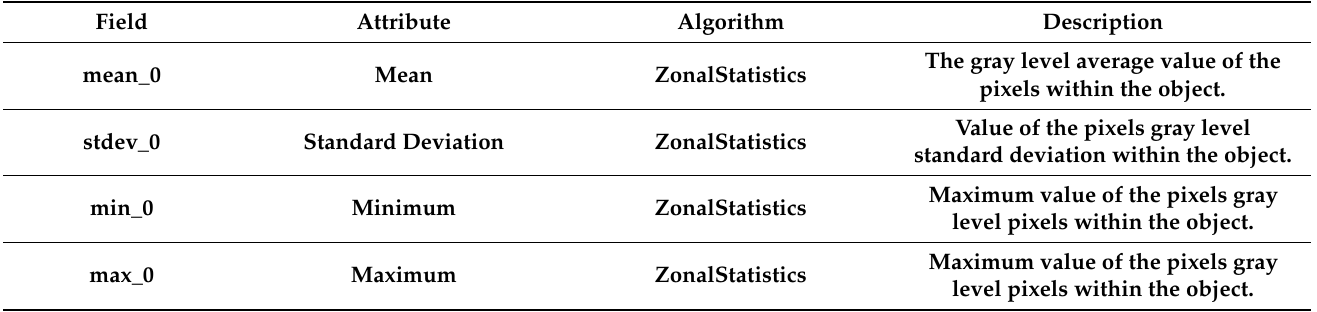
Table A2. Attributes calculated by the feature extraction function of the GeoDMA plugin in the TerraView software of INPE. Those highlighted in bold are calculated for each raster band used in the process. As an example, only the statistics of band 0 (B0) are